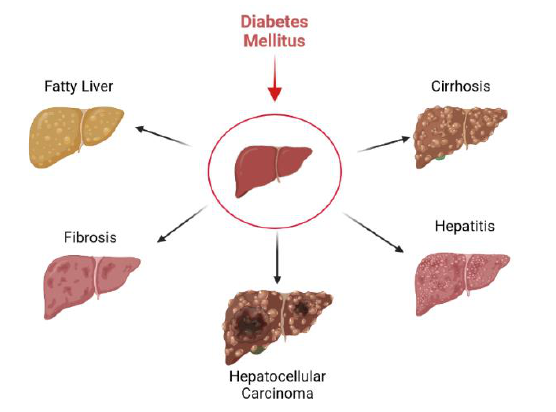
Figure 2: Uncontrolled diabetes induces a variety of hepatic